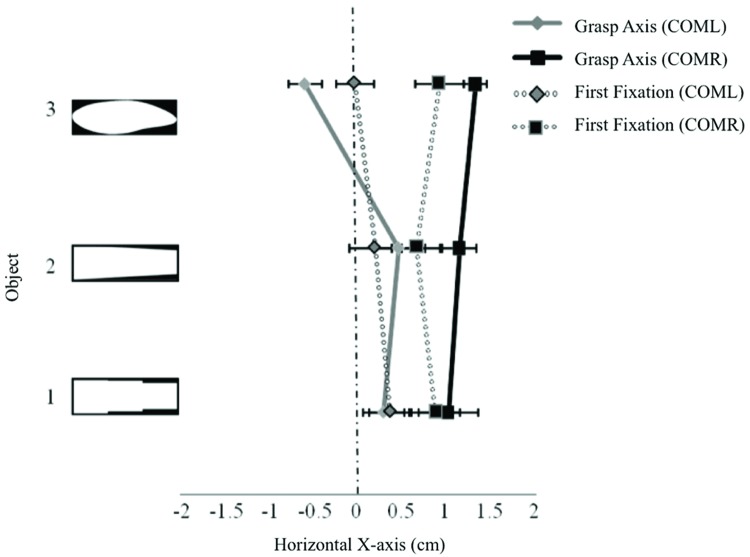
Shows the mean first fixation and grasp axis locations along the horizontal X-axis collapsed across COM distance for the three different object types in Experiment 2. Negative values represent positions that are located to the left of the object’s horizontal midline. Error bars represent the standard error of the mean.